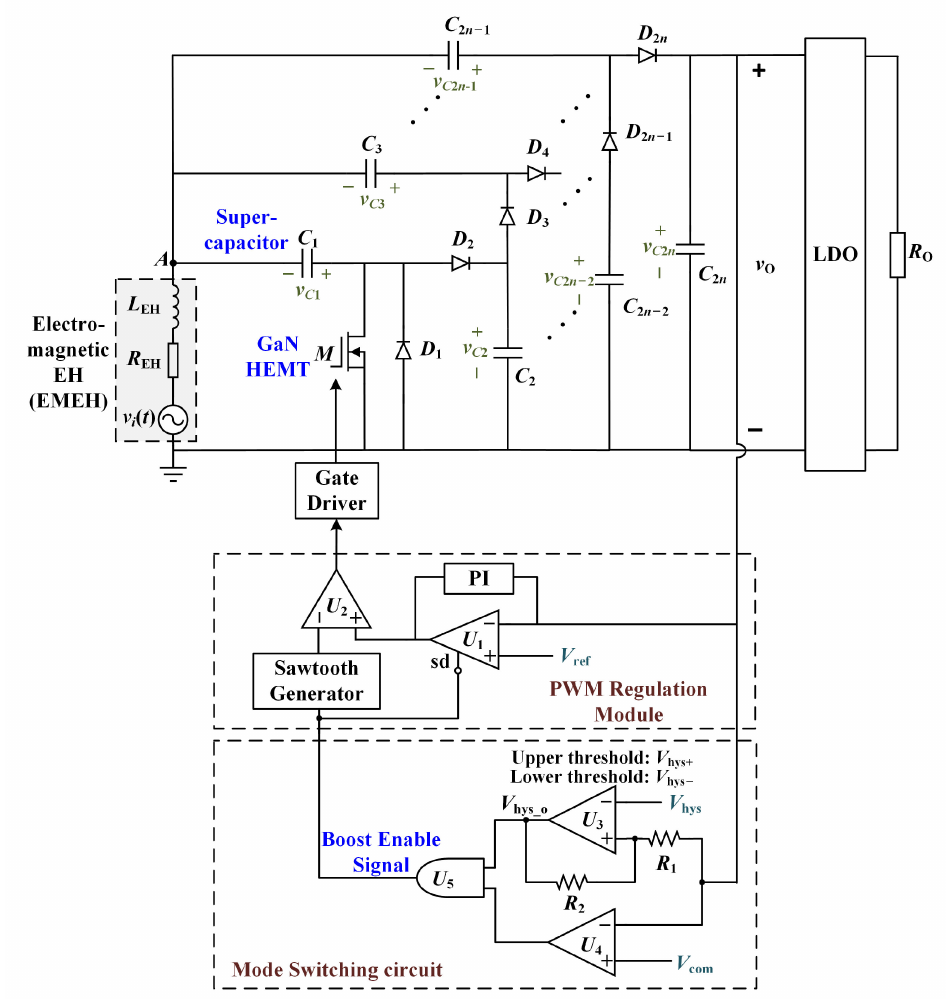
Figure 5. The full schematic of the proposed hybrid VM–boost